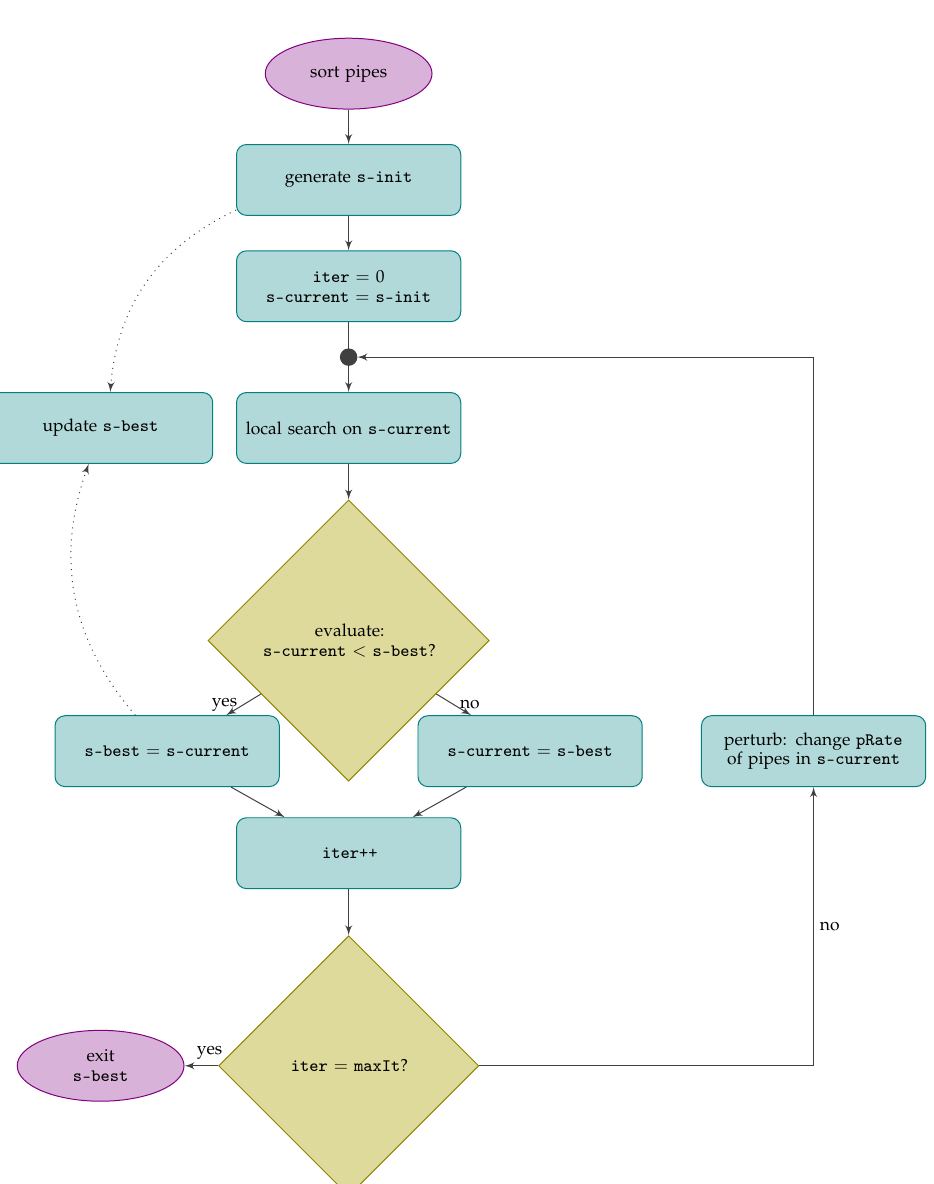
Figure 6. Flowchart of the iterated local search algorithm. s-best: initial global best solution; s-current: current solution; s-init: initial feasible